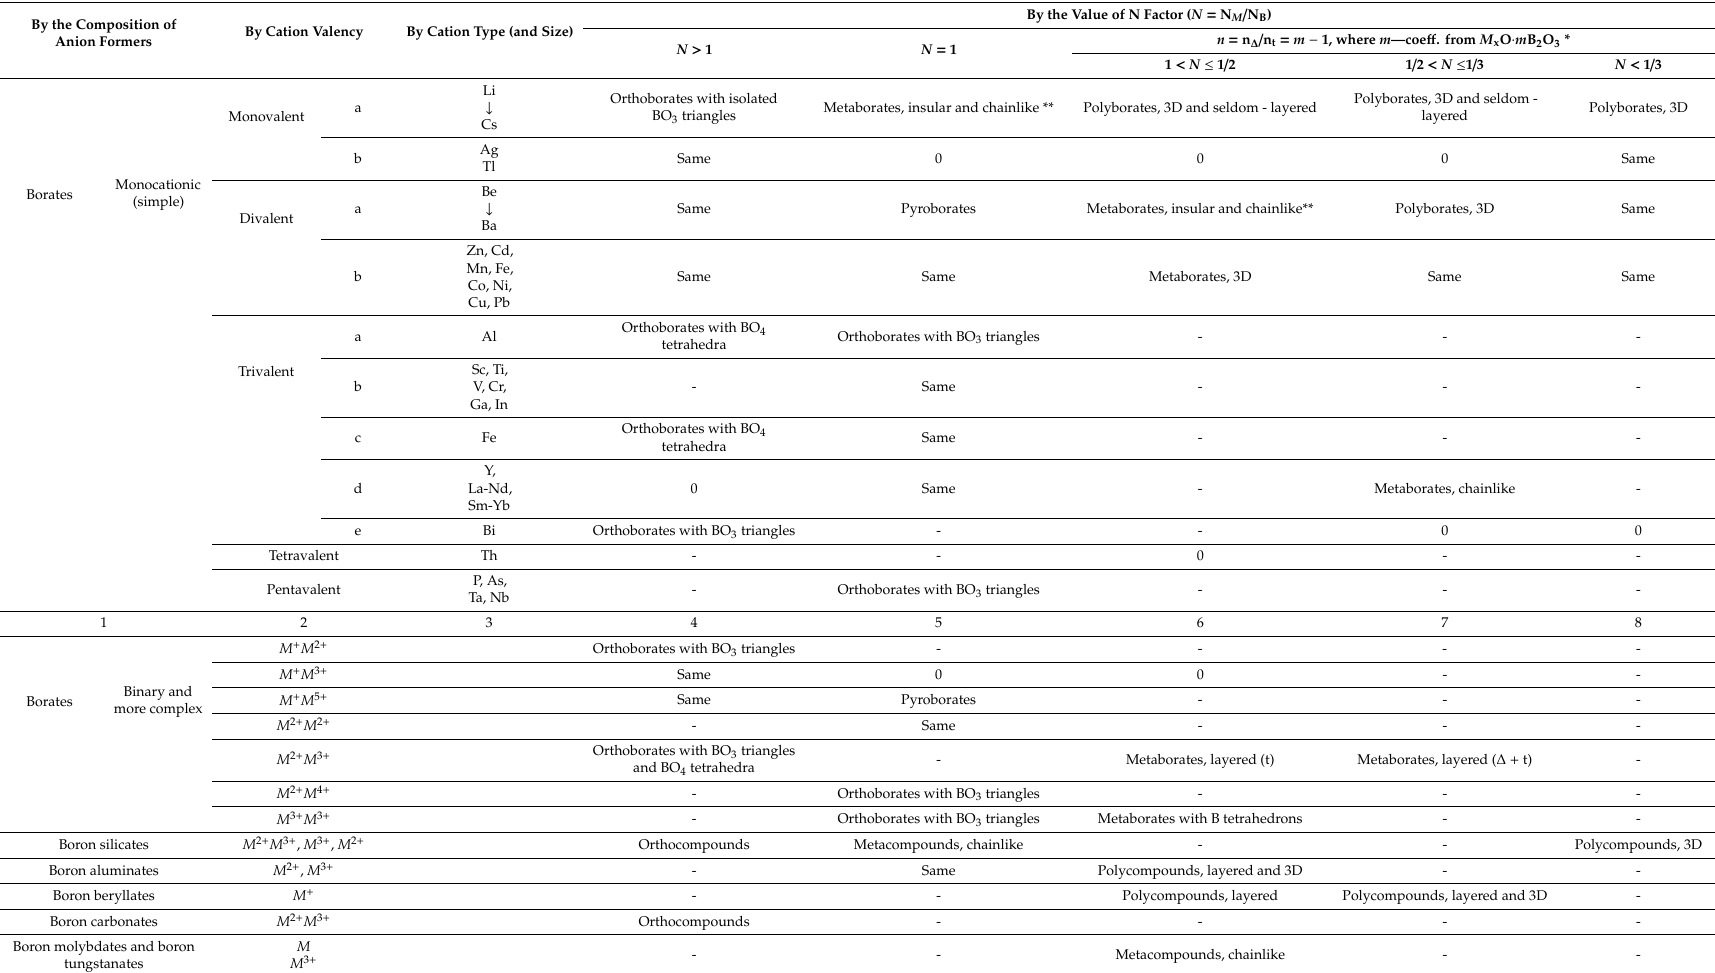
Table 5. Classification scheme of anhydrous